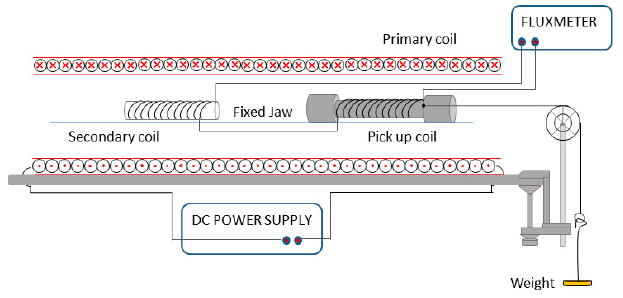
Figure 3. Experimental setup for measuring the Villari effect.